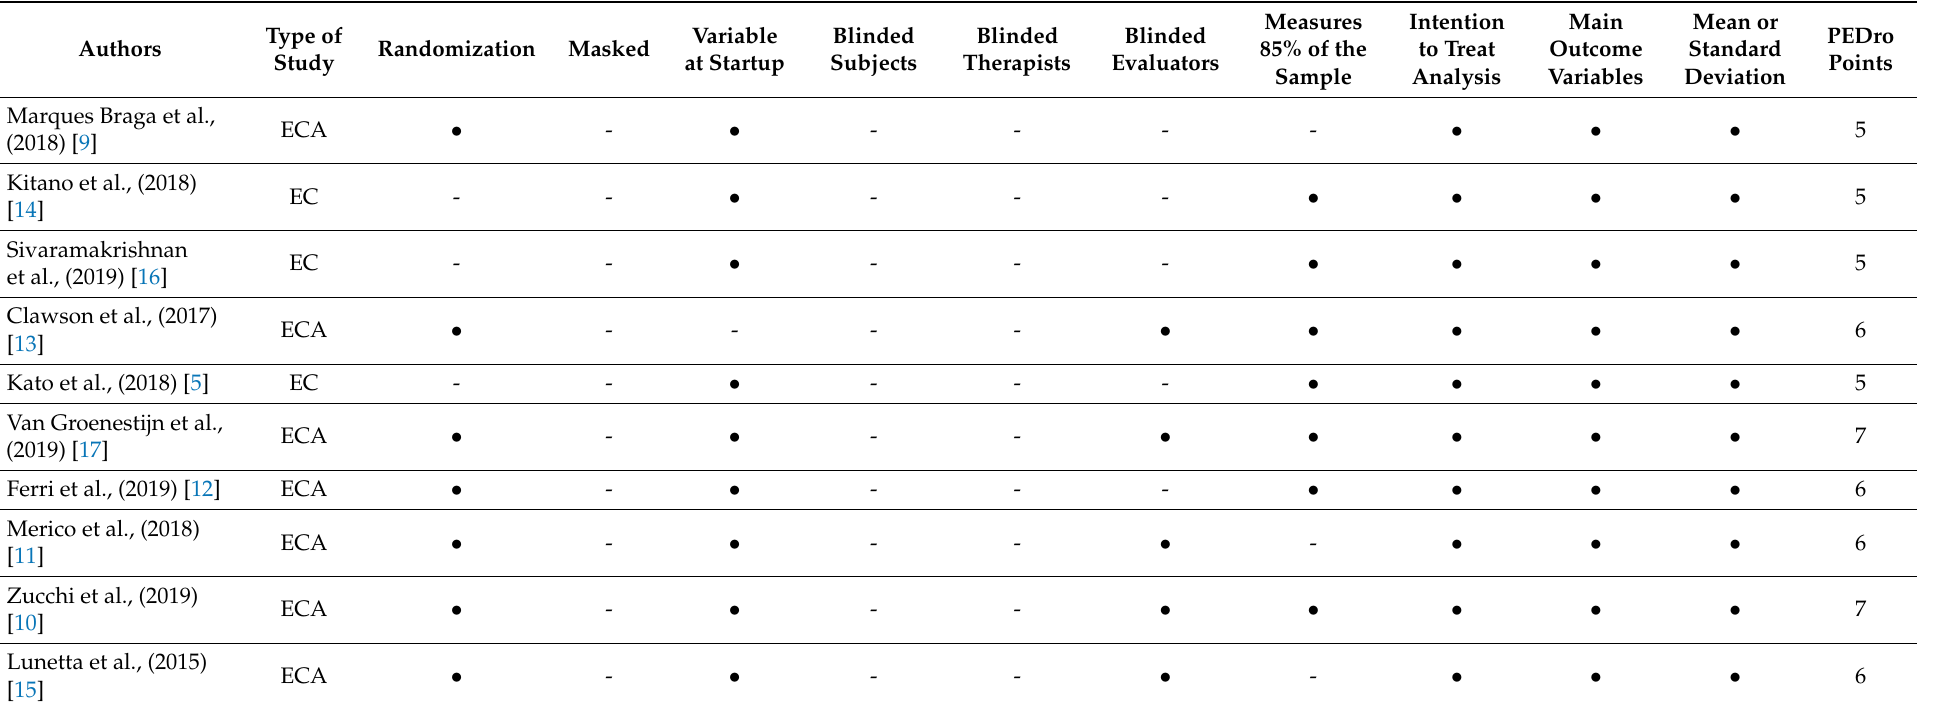
Table 1. Physiotherapy Evidence Database (PEDro) scale total score of the different studies